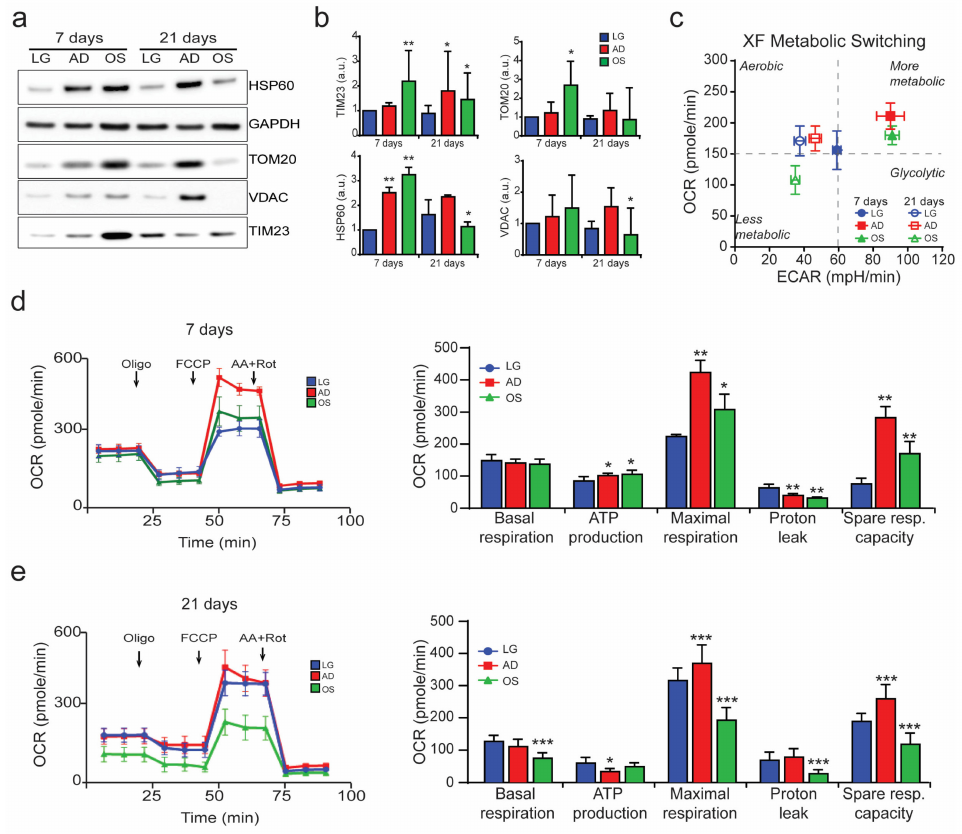
Figure 2. Mitochondria in MSC di ff erentiation processes. ( a ) Representative immunoblot and ( b ) quantification of HSP60, TOM20, VDAC, and TIM23 protein levels normalized to GAPDH levels. ( c ) XF phenograms representing the metabolic switching of MSCs during di ff erentiation, as detected using an Extracellular Flux Analyzer (Seahorse Bioscience). ( d , e ) Oxygen consumption rate (OCR) measurements and relative derived parameters after the addition of oligomycin [1 µ M], 1 µ M carbonylcyanide 4-(trifluoromethoxy)-phenylhydrazone (FCCP) [1 µ M], and antimycin A [2 µ M] + rotenone [2 µ M] in MSCs cultured in low-glucose (LG), adipogenic (AD), and osteogenic (OS) media for ( d ) 7 and ( e ) 21 days. Data are derived from ≥ 45 acquired cells / condition from ≥ 3 independent experiments and are shown as the mean ± SD. ANOVA, * p < 0.1, ** p < 0.01, *** p < 0.001, **** p < 0.0001 with respect to the LG condition at the same time